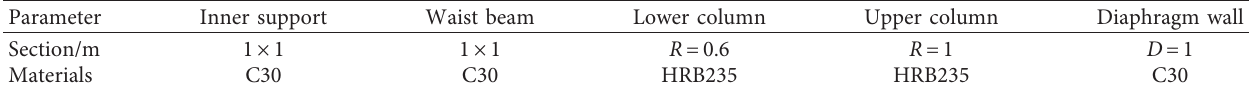
Table 5: Support structure